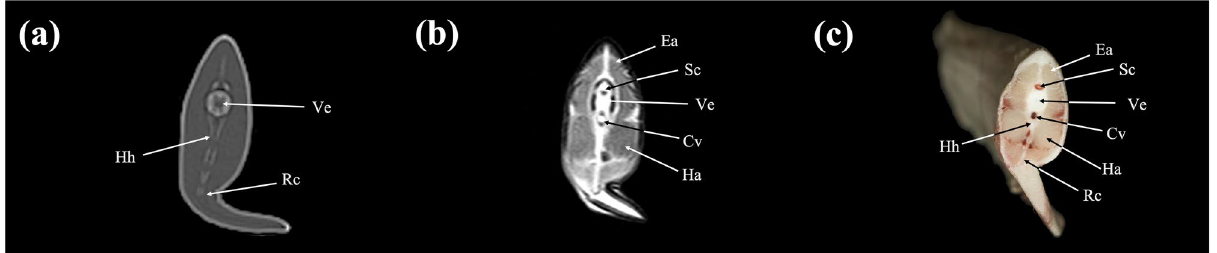
Figure 14. Transverse ( a ) CT, ( b ) MR, and ( c ) cryosection images of a banded houndshark ( Triakis scyllium ) at level 14 of Fig. 25. Cv Caudal vessel, Ea Epaxial, Ha Hypaxial, Hh Haemal arch, Rc Radial cartilage, Sc Spinal cord, Ve Vertebra.